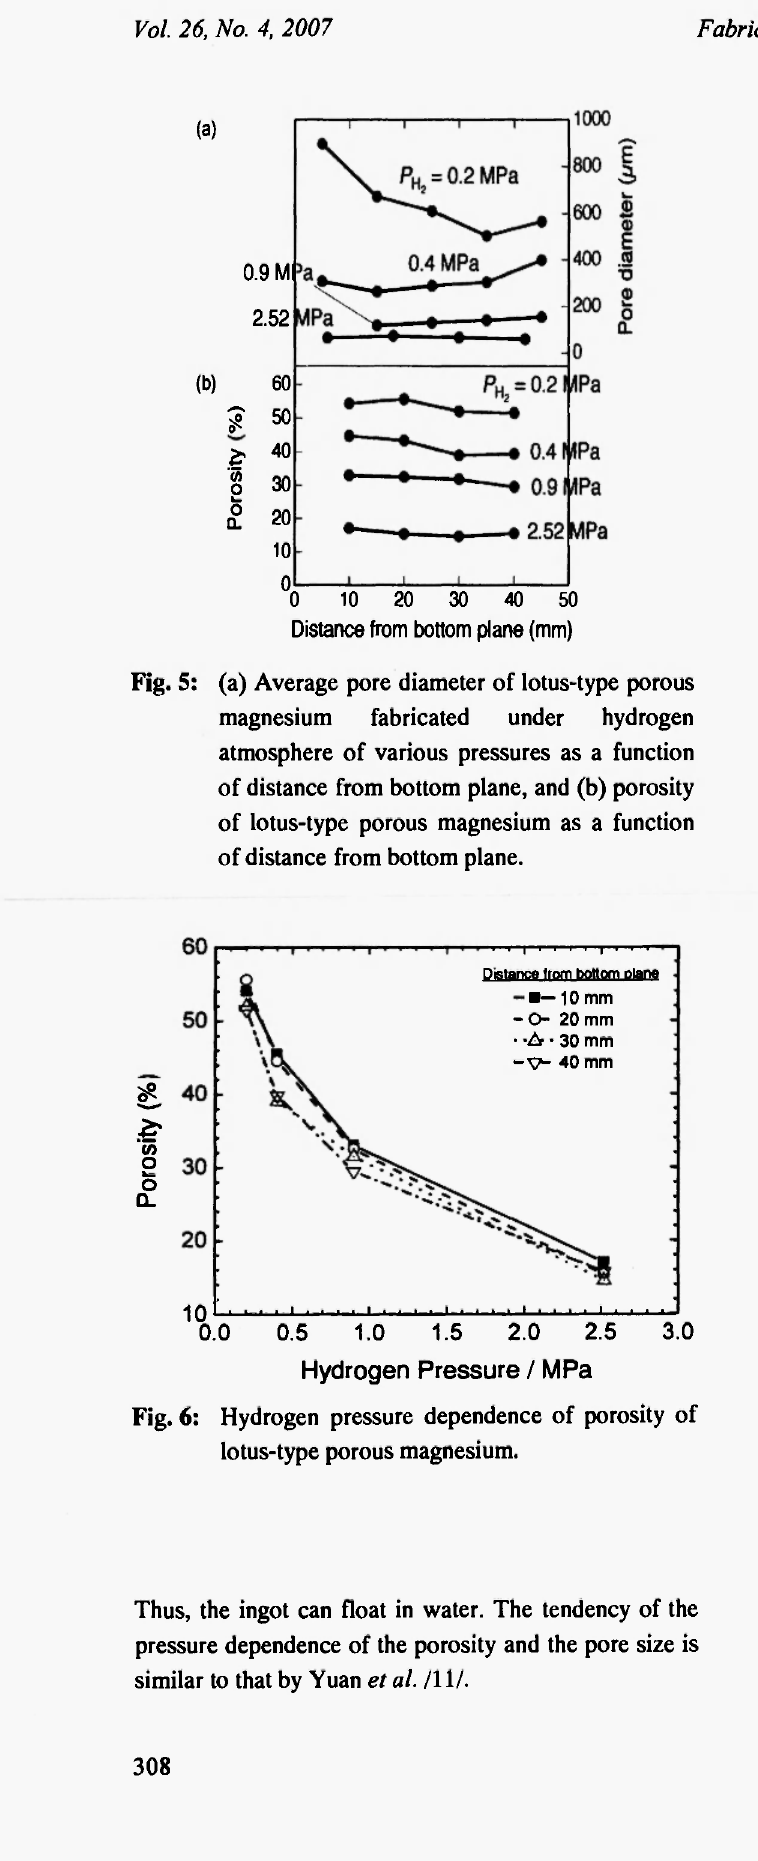
Thus, the ingot can float in water. The tendency of the pressure dependence of the porosity and the pore size is similar to that by Yuan et al. /II/.